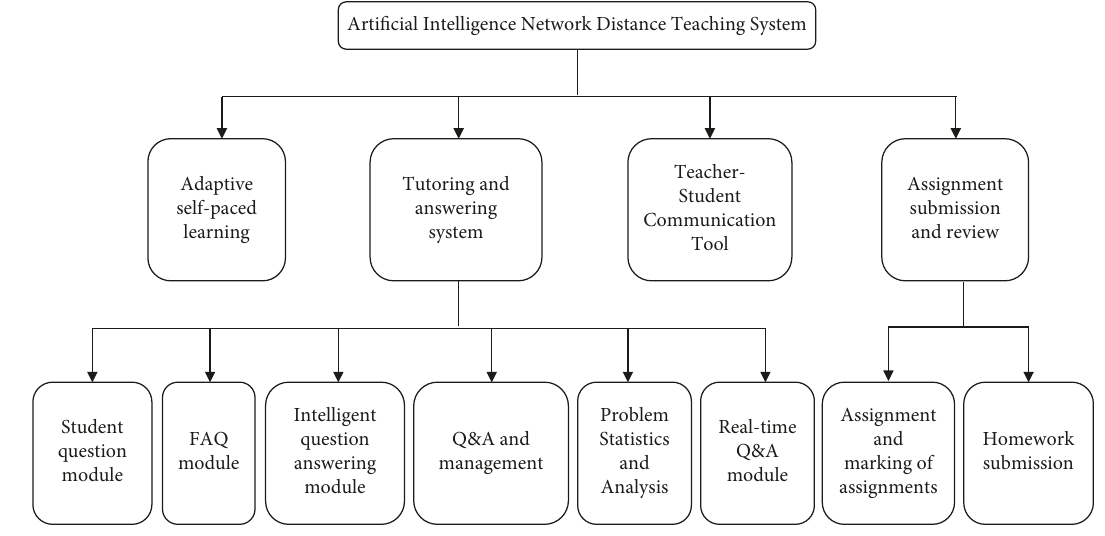
Figure 4: Software function design.